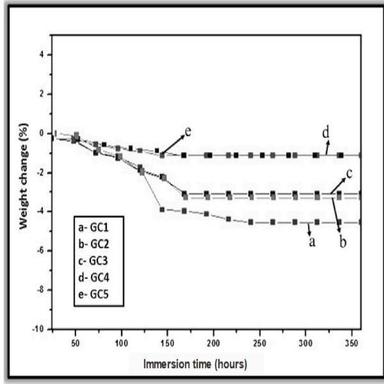
Weight change time curve of the developed geopolymer coating samples for 360 h water immersion.